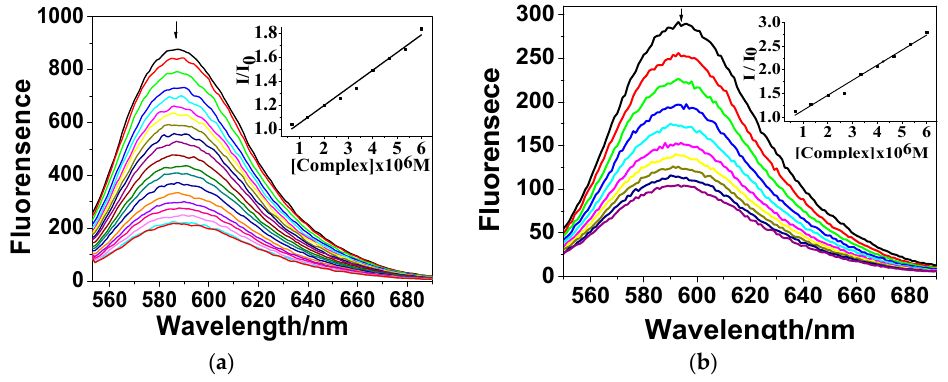
Figure 4. Emission spectra of ethidium bromide DNA (EB-DNA) in the incubation buffer in the absence and presence of complex 1b . [EB] = 16 μ M, [CT DNA] = 1 μ M, [ bcl-2 G4 DNA] = 100 μ M. Arrow shows the emission intensity changes upon increasing concentration of 1b . ( a ) EB-CT-DNA; ( b ) EB- bcl-2 G-quadruplex DNA.